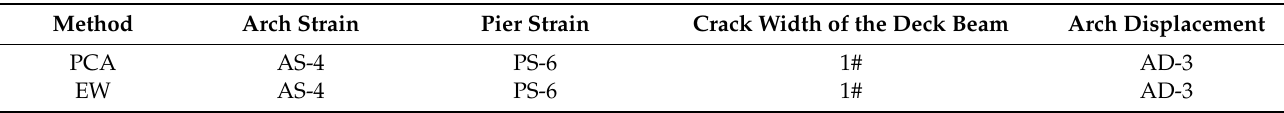
Table 10. Key measuring point selection for multivariable